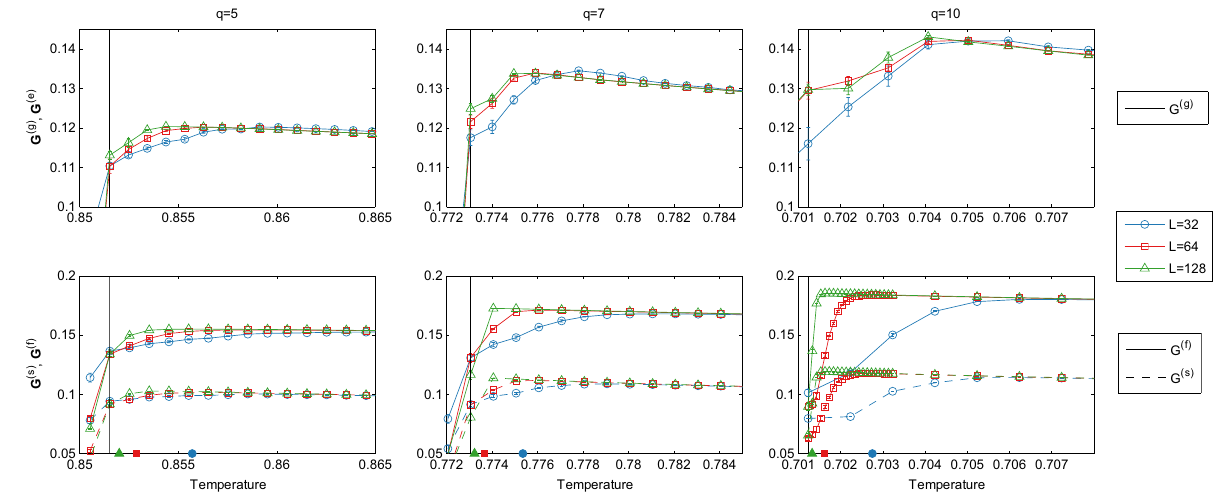
5, 7, 10 (columns) for = c . Filled